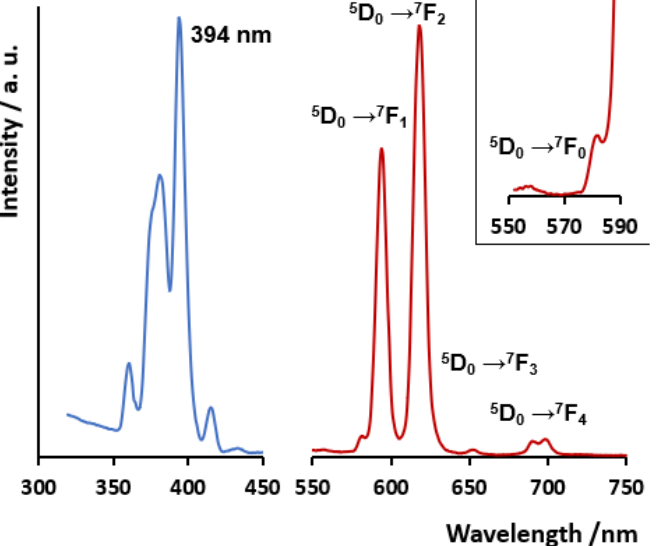
Figure 4. ( Left ): solid-state excitation spectra. ( Right ): emission spectra of compound 2 excited at 394 nm. Transitions assigned to each band are also shown. An inset is included for more detail on the 5 D 0 → 7 F 0 band.